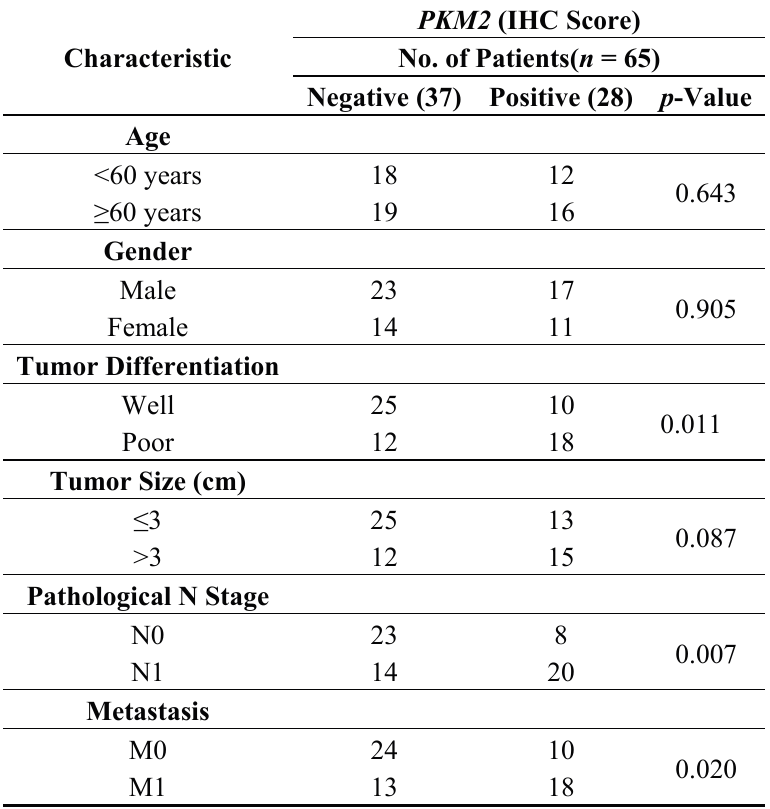
Table 1. Correlation between PKM2 expression and the clinicopathological features.